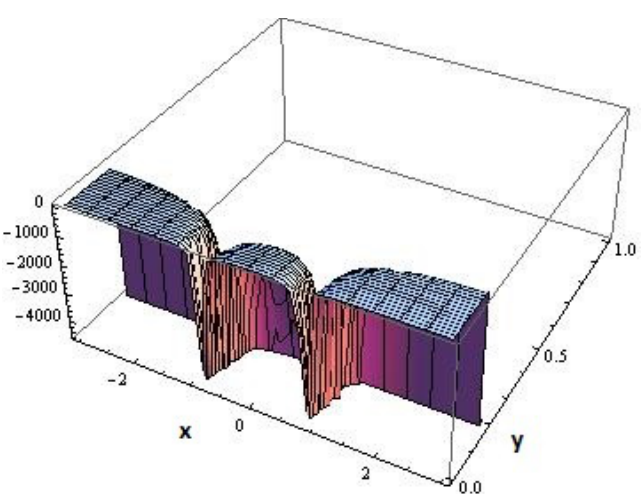
Figure 9. The scalar curvature R concerning the free energy fluctuations as a function of the vacuum parameter x : = θ and temperature y : = T , describing fluctuations of the YM vacuum ensemble for a given anomaly factor c , decoherence temperature d , and critical exponent e